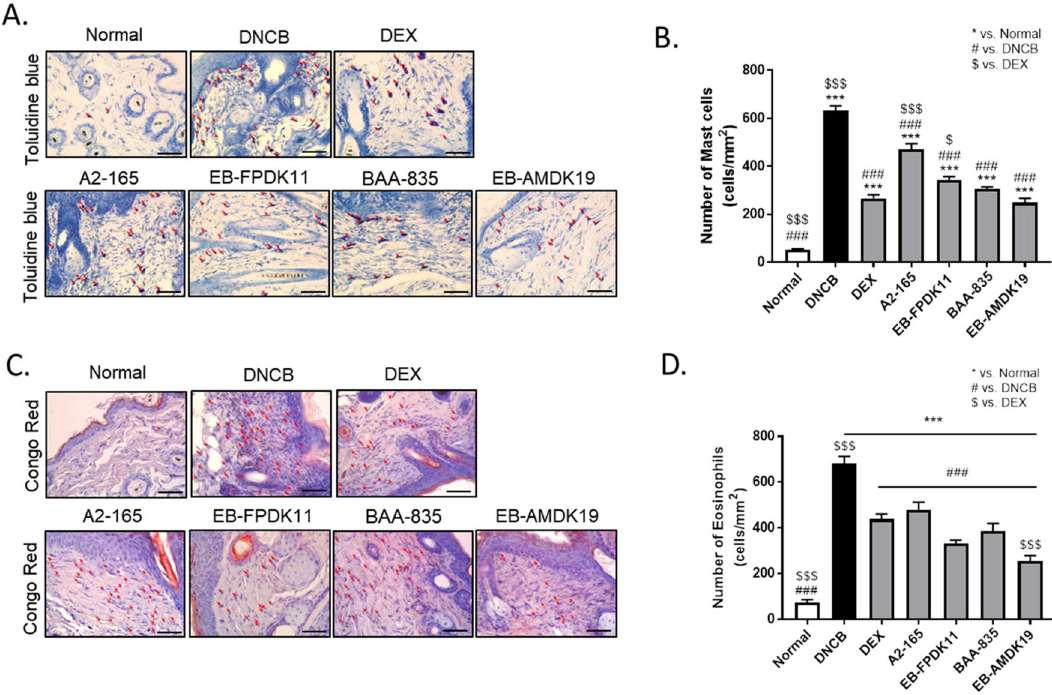
Figure 3. EB-FPDK11 and EB-AMDK19 inhibit mast cell and eosinophil infiltration into dermis in DNCB- induced AD-like mice. ( A , B ) Mast cell infiltration in the dorsal skin of mice. Mast cells were stained with Toluidine Blue. Scale bar, 100 µm. ( C , D ) Eosinophil infiltration in the dorsal skin mice. Eosinophils were stained with Congo Red. Scale bar, 100 mm. The red arrows indicate positively stained cells. Data are presented as mean ± SEM of changes in values. * P < 0.05; ** P < 0.01; *** P < 0.001, *versus normal group; # versus DNCB group; $ versus DEX